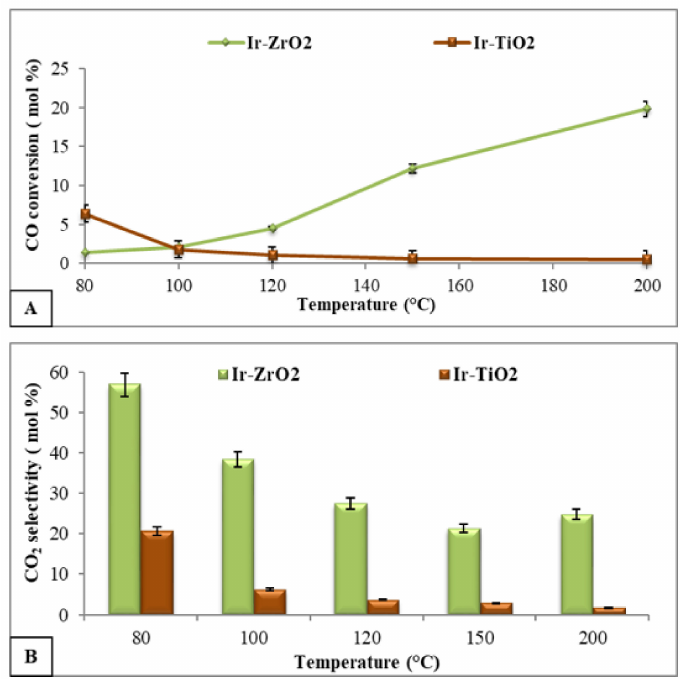
Figure 9. CO conversions ( A ) and selectivity towards CO 2 ( B ) for the TiO 2 and ZrO 2 supported Ir catalysts (GHSV 12,000 h − 1